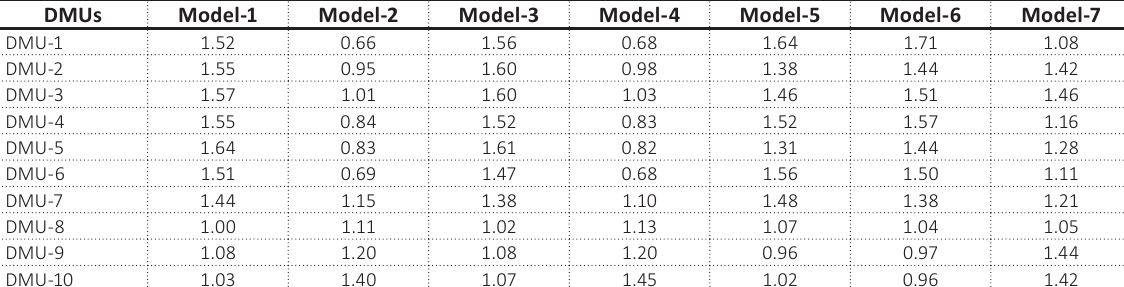
Figure 3. Change in total productivity of Saudi Arabian banks Table 7. The scores of total productivity change of Saudi Arabian